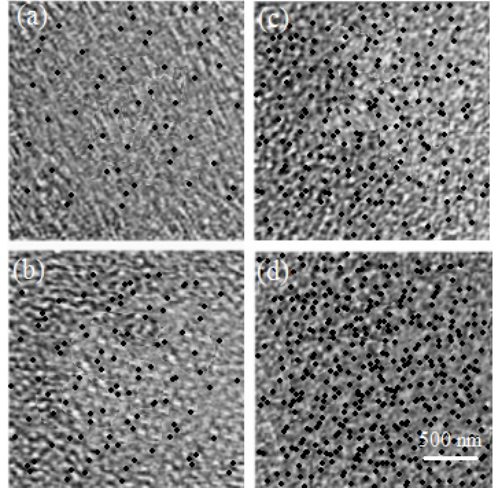
Figure 1. TEM illustrations of polymer nano-composite polystyrene films at different silica loading: ( a ) 1%; ( b ) 5%; ( c ) 7.5%; and ( d ) 15%.